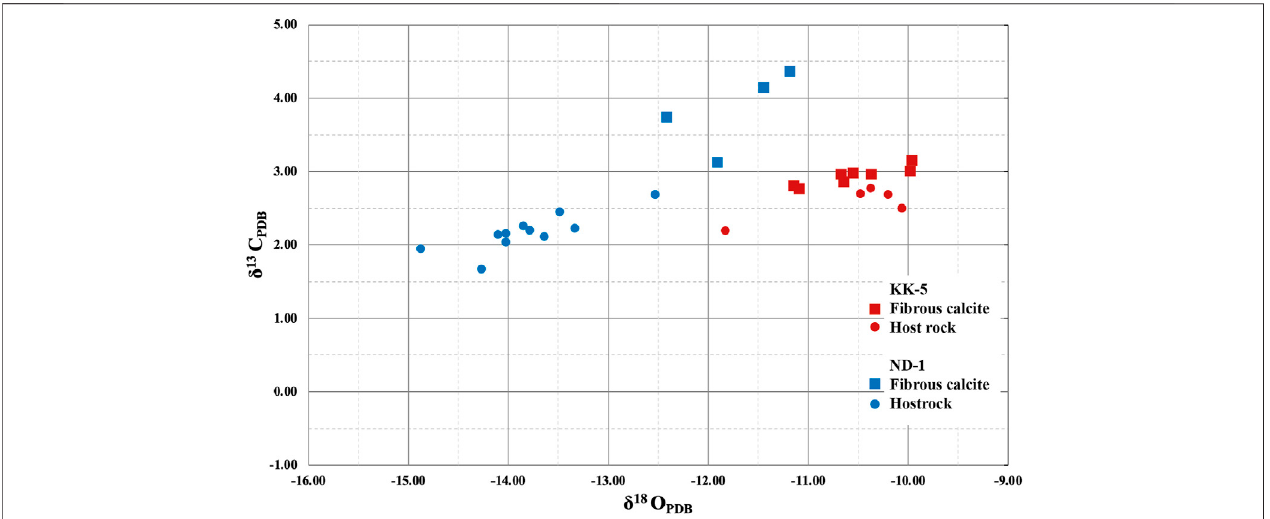
FIGURE 8 | Carbon and oxygen isotope compositions from the fi brous calcite vein and host rock of the Khao Khwang (KK-5) and Nam Duk (ND-1) samples.